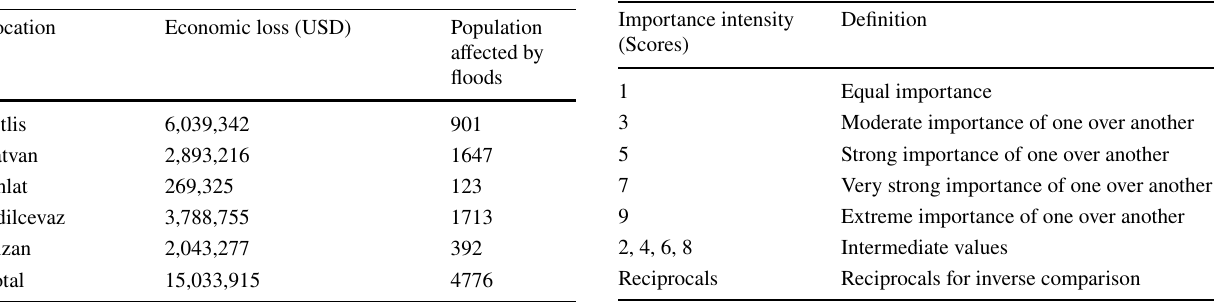
Table 2 Scales for pairwise comparison in AHP (Wang et al. 2008; 500 annual flood Saaty